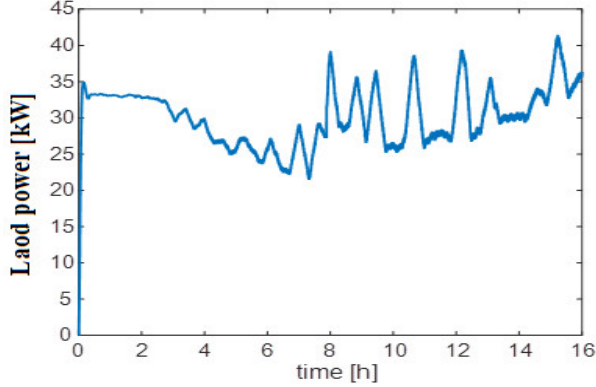
Figure 14. Power demand of the load.